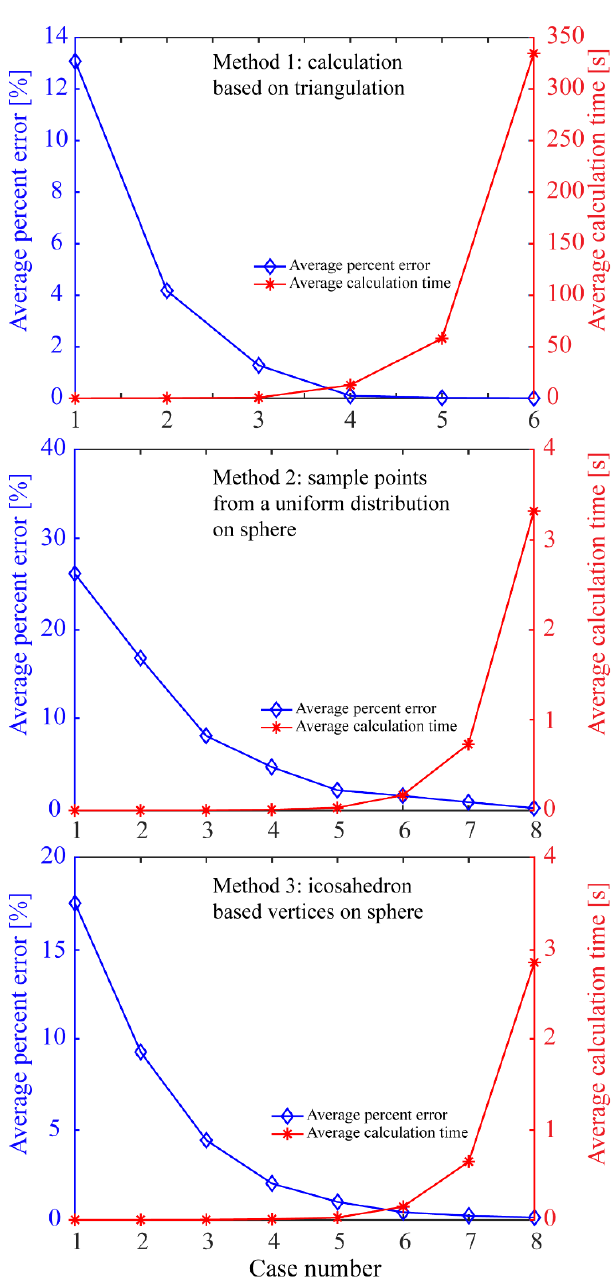
Figure 7. Average percent error and average calculation time from three methods. The blue plots with diamond markers are the average percent error which follows the vertical axis on the left side. Each data point is the average over 800 area calculations for 100 cells. The values from the triangulation method with 333,064 vertices on the disk domain are used as the exact values. The red plots with asterisks are the average calculation time that uses the axis on the right side. The average time is calculated from 30 repetitions of the 800 area calculations for 100 cells. The horizontal axes are all case numbers which are listed in Table 1.